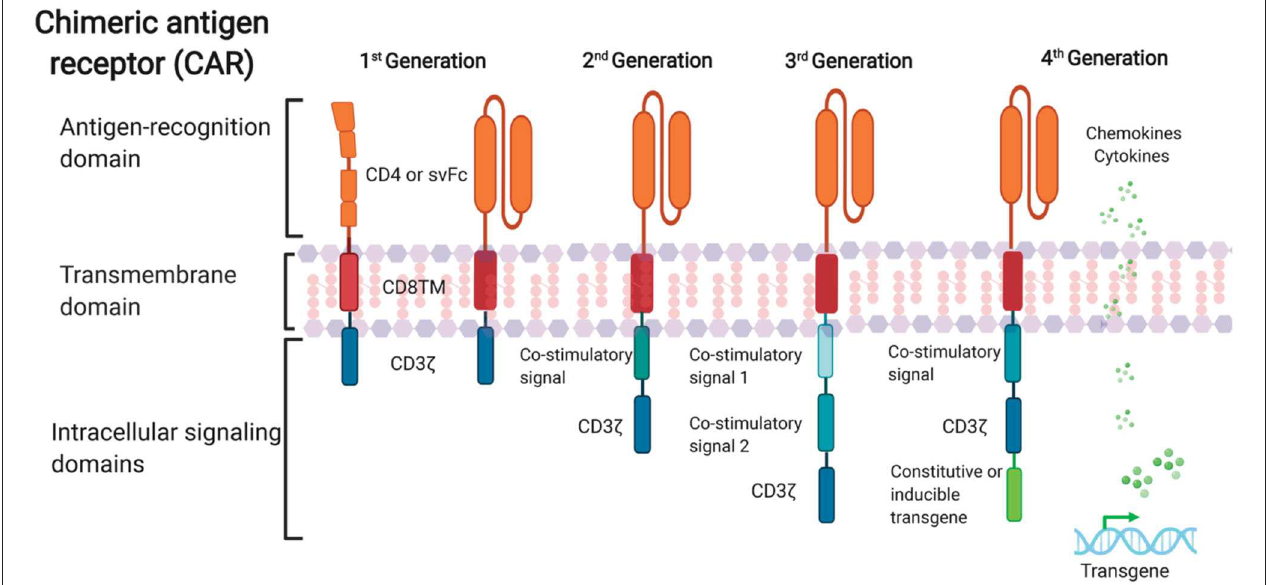
FIGURE 1 | Schematic representation of anti-HIV CAR structure. First-generation CAR consists of a single anti-HIV env domain (CD4 or svFc), the transmembrane domain region, and the T cell receptor CD3- ζ domain. Second-generation CAR incorporates an additional costimulatory signaling domain to the basic first-generation receptor configuration. Third-generation contain more than one co-stimulatory domain. Fourth-generation CARs are characterized by addition of constitutive or inducible transgenes like cytokines or